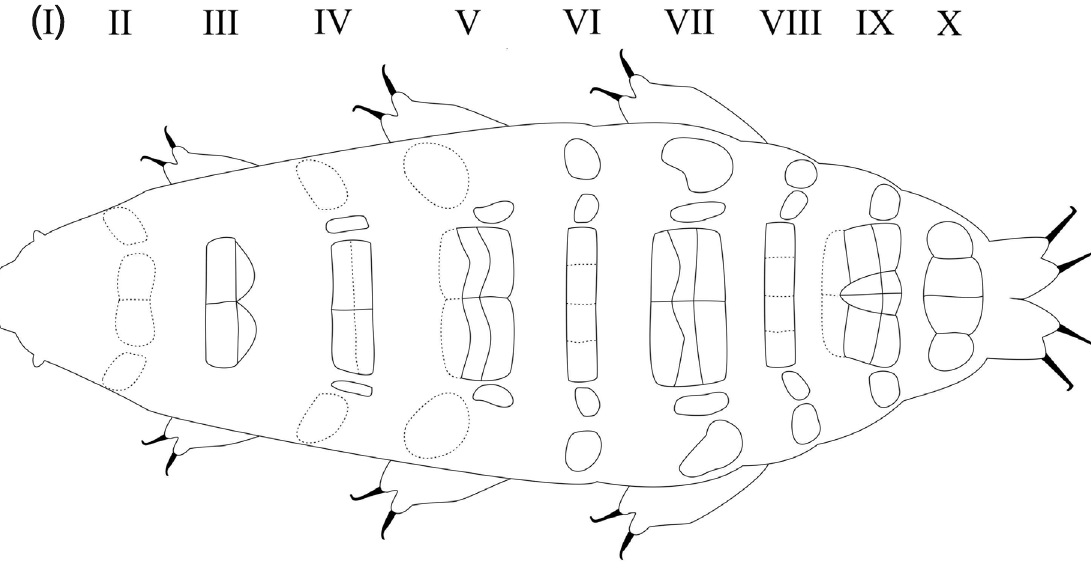
Fig. 15. Semi-schematic drawing of pseudoplate configuration in Milnesium irenae sp.